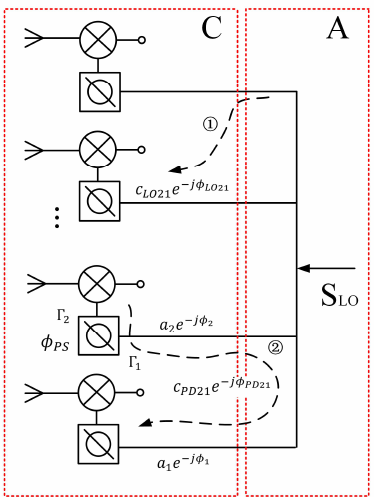
Figure 6. Simplified block diagram of phased array with two different LO coupling paths.